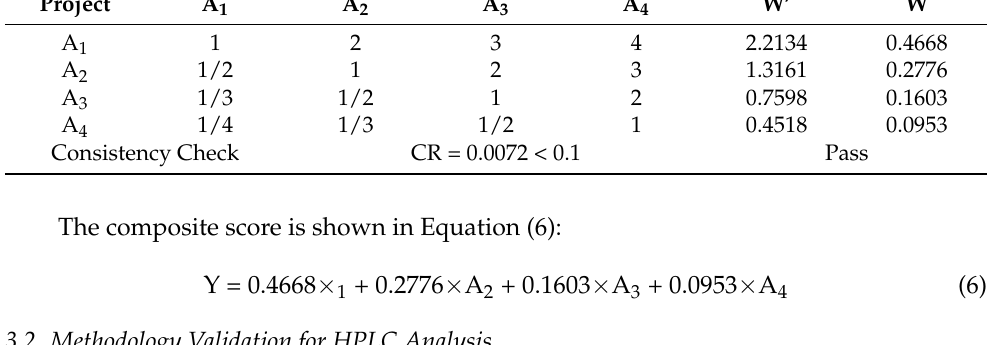
Figure 3. Chromatographic profiles of analytes and spiked sample. 1: Dihydromyricetin; 2: Taxi folin; 3: Myricetin; 4: Quercetin. Table 4. Standard curve equation detection. Four Flavonoids